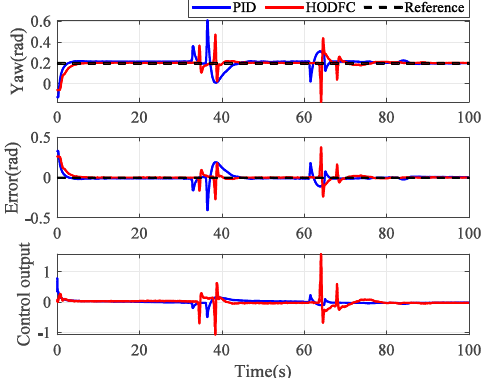
Figure 17. Experimental results of yaw with human interference.